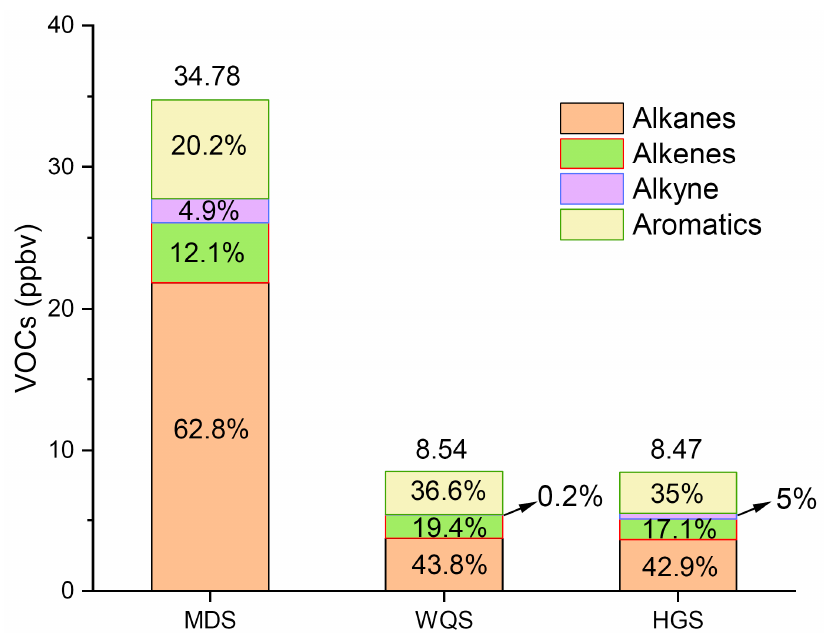
Figure 2. The group compositions (alkanes, alkenes, alkyne and aromatics) of volatile organic compounds (VOCs) at the three sites.